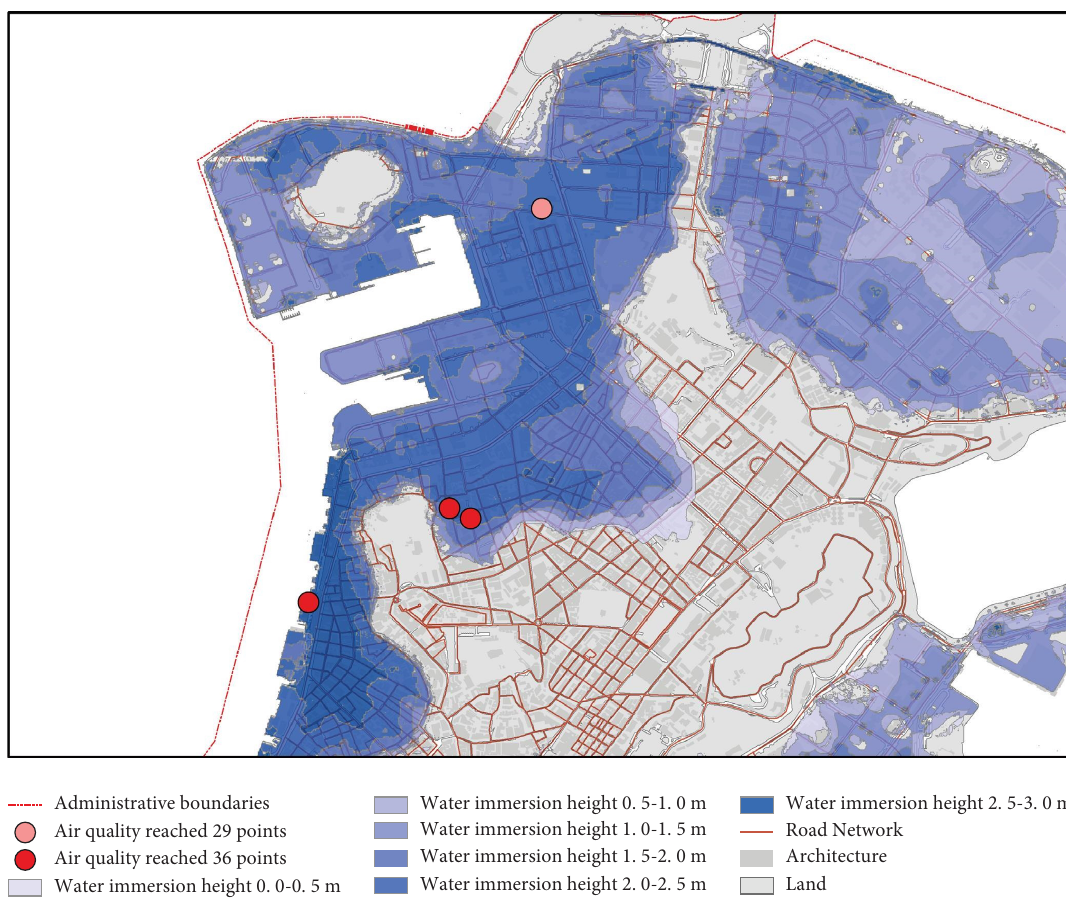
Figure 3: Assessment of Macau’s urban renewal space adaptability (source: self-drawn by the